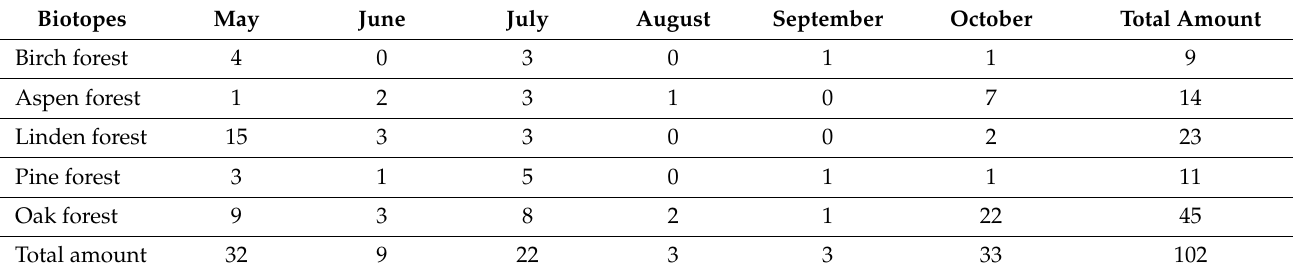
Table A9. Seasonal dynamics of Leucophenga quinquemaculata in five